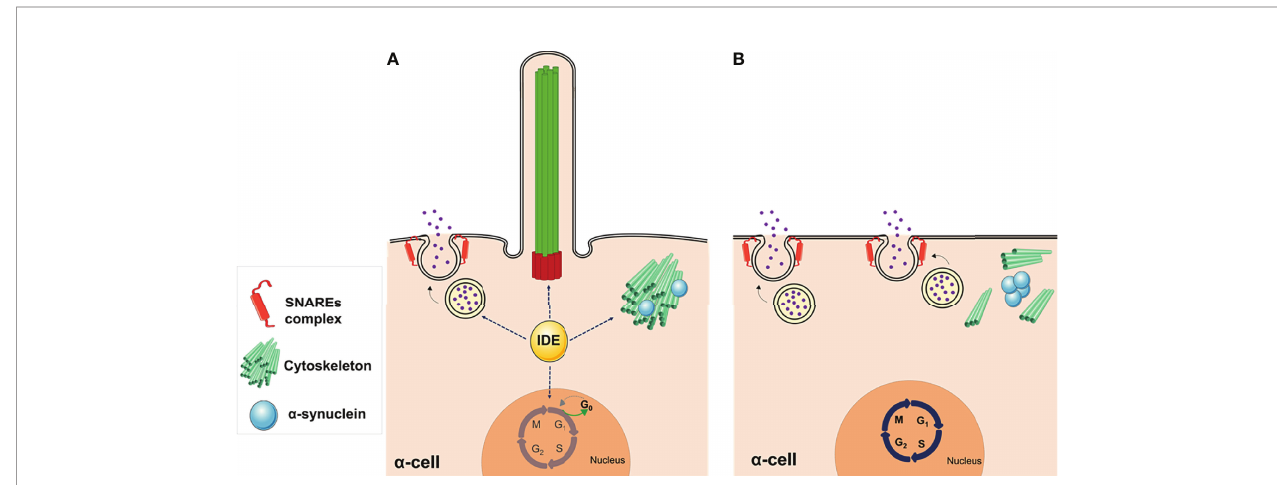
FIGURE 5 | Non-proteolytic functions of IDE in a -cells. (A) The abundance of IDE in pancreatic a -cells is relevant for maintaining several cellular functions, such as glucagon secretion, cytoskeletal organization, and ciliogenesis, while cells are maintained in a quiescent state. (B) Deletion of IDE in mouse a -cells revealed multiple phenotypes, such as hyperglucagonemia, hyperplasia, and hypertrophy, suggesting different non-proteolytic functions of IDE in these cells. Lack of primary cilia along with increased proliferation, in Ide depleted a -cells, provide direct functional evidence for the involvement of cilia in a -cell proliferation. Likewise, loss of IDE causes a - synuclein aggregation, which might underlie the absence of cilia, cytoskeletal alterations, and augmented SNARE proteins of the secretory machinery. This fi gure was created using Servier Medical Art (available at